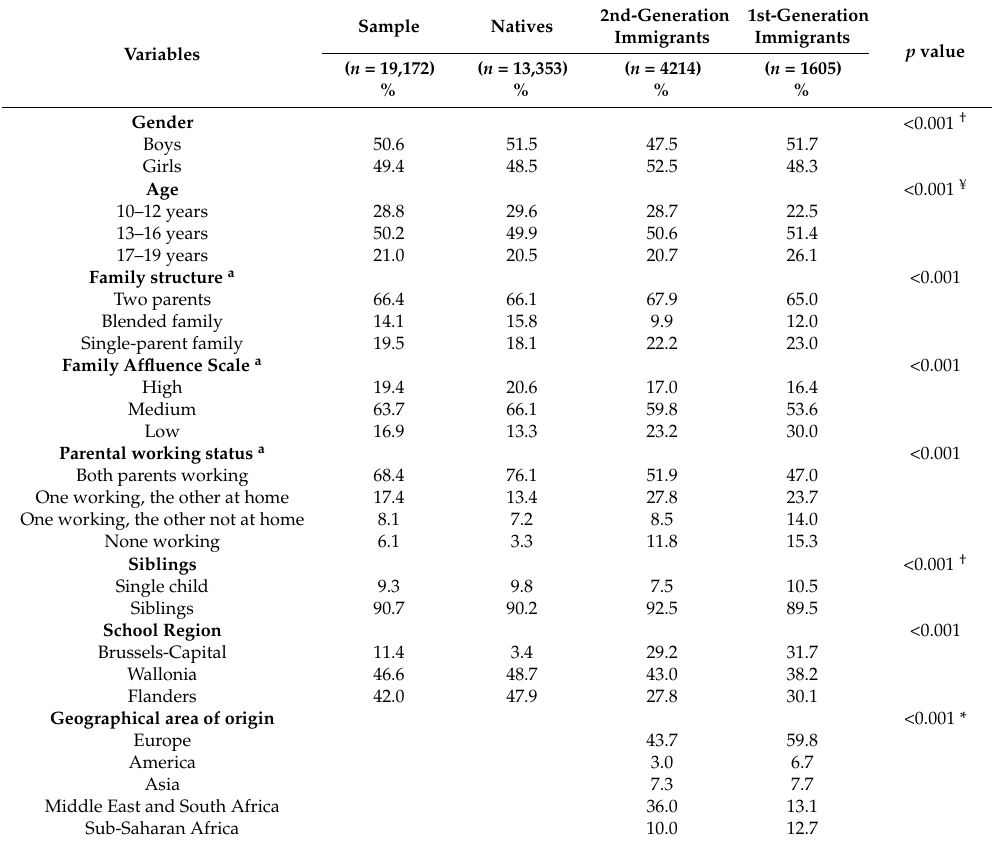
Table 1. Sociodemographic and socioeconomic characteristics of the sample overall and by migration status—HBSC, Belgium,